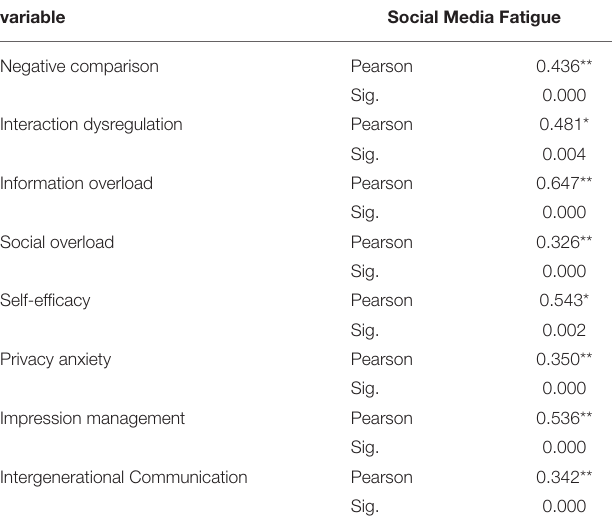
TABLE 3 | Correlation analysis